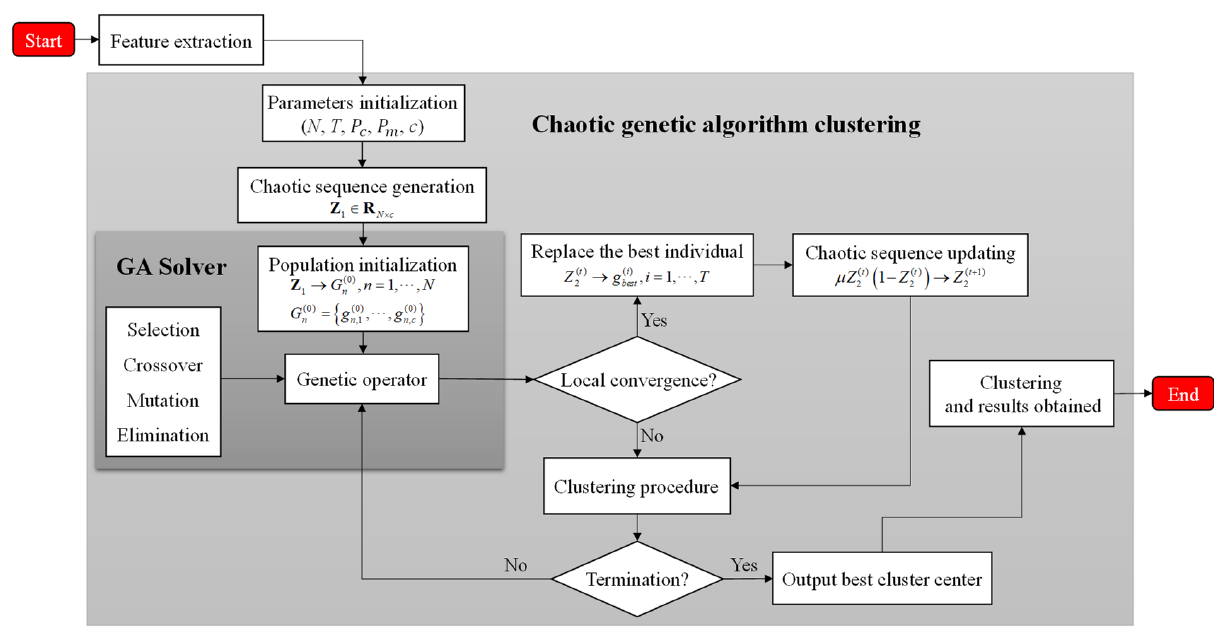
Figure 7. Chaotic genetic algorithm clustering flowchart.